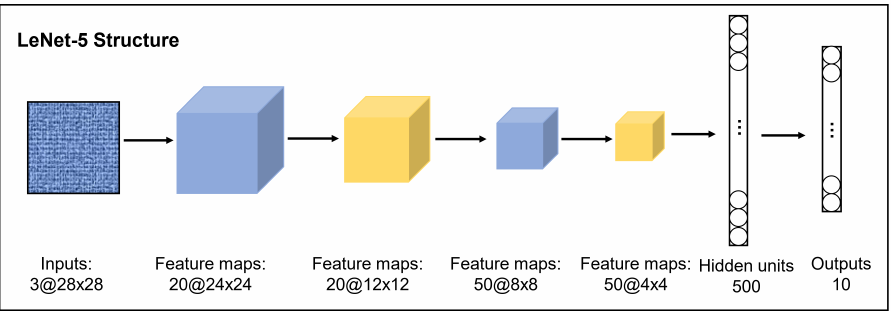
Figure 6. Structure of LetNet-5 [19].